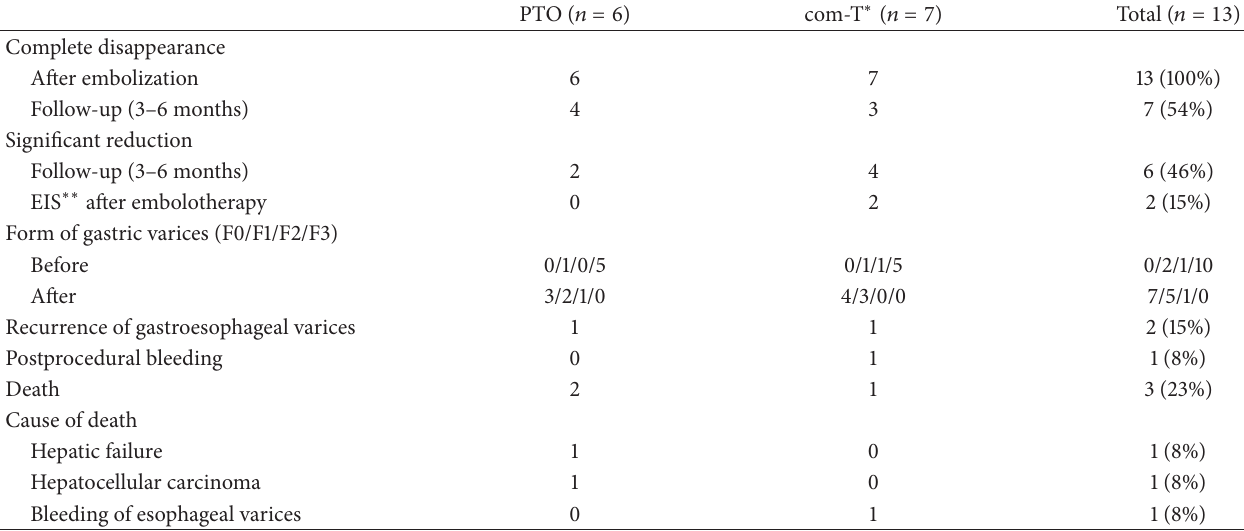
Table 2: Results of the 13 patients treated with PTO or Combined PTO and BRTO.